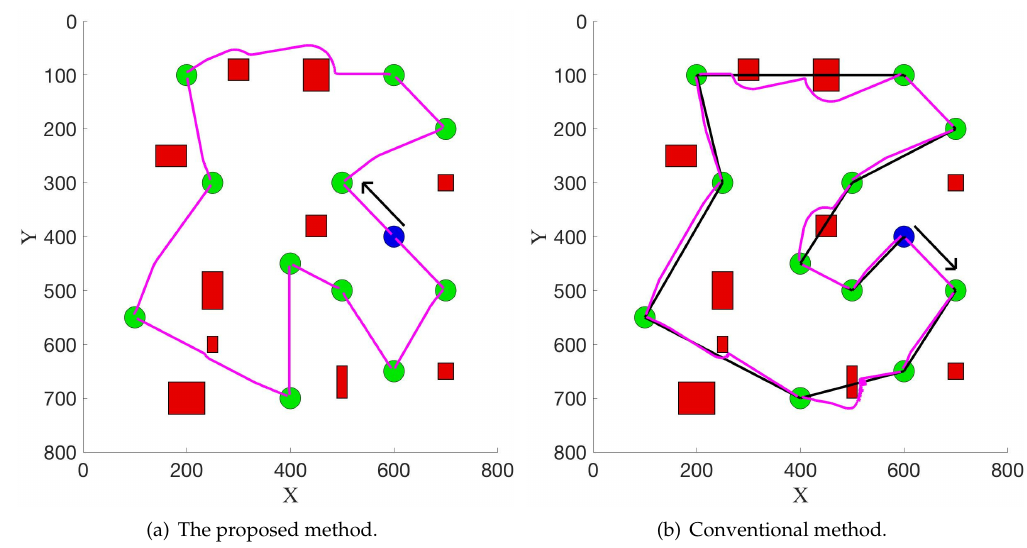
Figure 4. Experimental results in the first